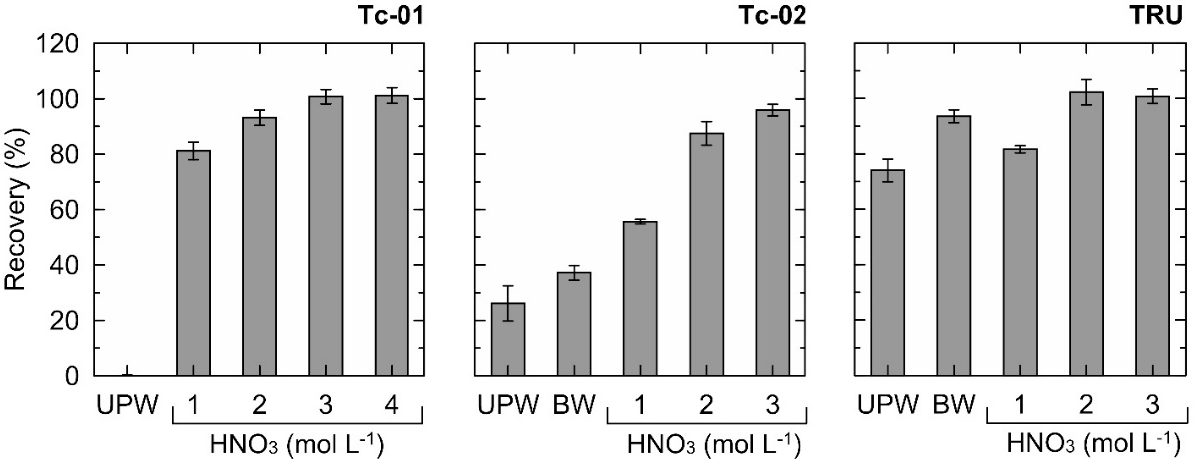
Figure 2. Effect of eluent variants (UPW, ultrapure water; BW, boiling water; HNO 3 of varying molar concentrations) on the Re recovery from the ECRs. Feed solution volume, 4 mL (Tc-01, pH 1; Tc-02, pH 4; TRU, pH 2); C Re , 250 µg L − 1 ; eluent volume, 4 mL (UPW, BW, 1 to 4 mol L − 1 HNO 3 ); sample loading and elution flow rates, 0.5 mL min − 1 ; n = 3.